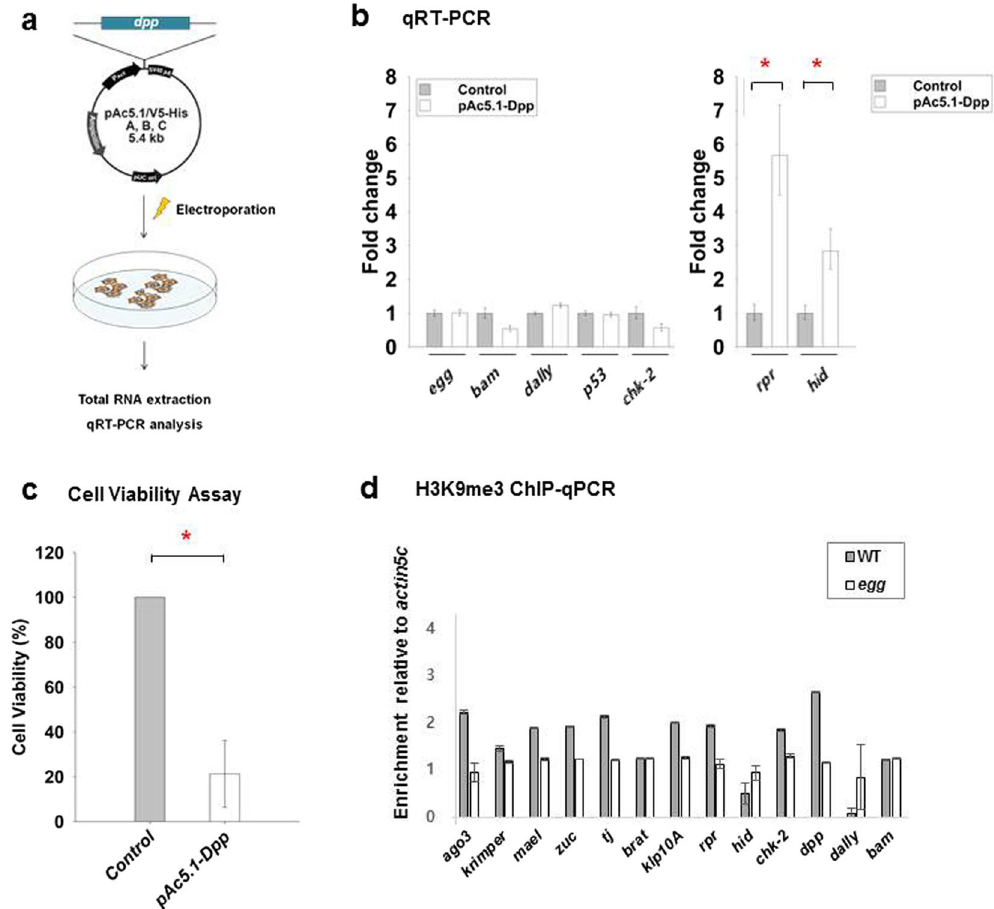
Figure 4. dpp overexpression induces apoptotic cell death through activation of rpr and hid in Drosophila ovarian somatic cells (OSCs). ( a ) Schematic illustration of Dpp overexpression experiments in OSCs. ( b ) qRT- PCR assays. dpp overexpression activated the expression of rpr and hid in OSCs. qRT-PCR assays show changes in expression levels of seven representative genes ( egg , bam , dally , p53 , chk-2 , rpr , and hid ) following dpp overexpression in OSCs (unpaired t -test; * P < 0.05; error bars represent standard deviation of three biological replicate experiments). ( c ) MTS assays. dpp overexpression induced cell death in OSCs. MTS assays show that the viability of dpp -overexpressing OSCs is significantly decreased (unpaired t -test; * P < 0.05; error bars represent standard deviation of three biological replicate experiments). ( d ) Chromatin immunoprecipitation (ChIP)-qPCR assays. ChIP was performed using H3K9me3 antibody to measure enrichment levels of H3K9me3 in the putative target genes of Egg. The recovered DNA was analyzed by qPCRs. Certain levels of H3K9me3 were present in some of the putative target genes such as dpp , rpr , chk-2 , ago3 , zuc , mael , tj , and klp- 10A genes. H3K9me3 levels in these genes were significantly reduced in egg mutant ovaries. The enrichment levels are relative to act5C . Error bars represent standard deviation of three biological replicate